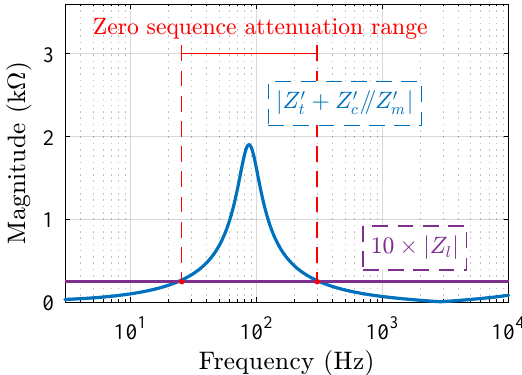
Figure 6. Evaluation of the zero sequence attenuation range for resistive loads ( | Z l | = Z base and PF = 1). Analysis for S x closed: attenuation range between 25 and 301 Hz.